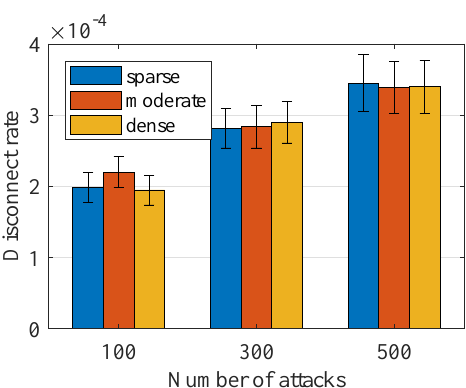
Figure 7. The simulation set up.